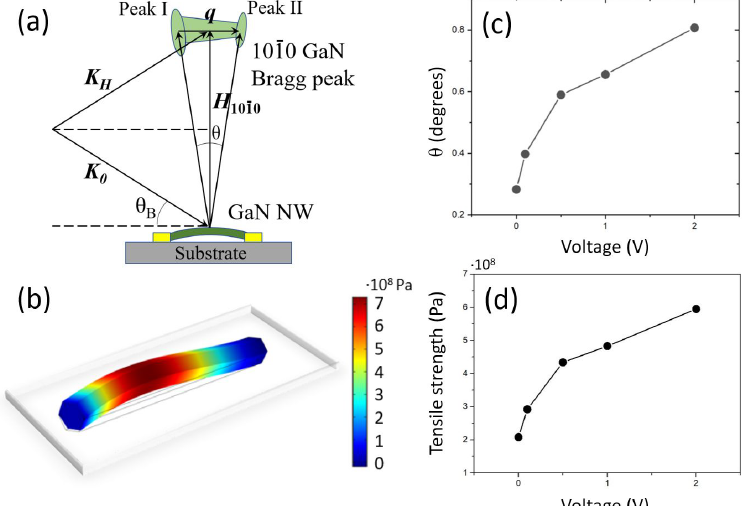
Figure 7. ( a ) Scheme of reciprocal space X-ray intensity distribution formation. ( b ) 3D FEM model of the bent GaN NW. The color scale bar gives values of the tensile strength obtained in this model. ( c ) Bending angle θ of the NW with the size of 350 nm as a function of the applied voltage bias. ( d ) Maximum tensile strength in the NW under voltage bias. The stress in the NW is increased from 2 × 10 8 Pa up to the ultimate tensile strength of 6 × 10 8 Pa, at which the NW was broken. For the free-lying NW with the diameter of 200 nm, an average bending angle of 0.45 degrees was calculated from the distance q between two peaks in reciprocal